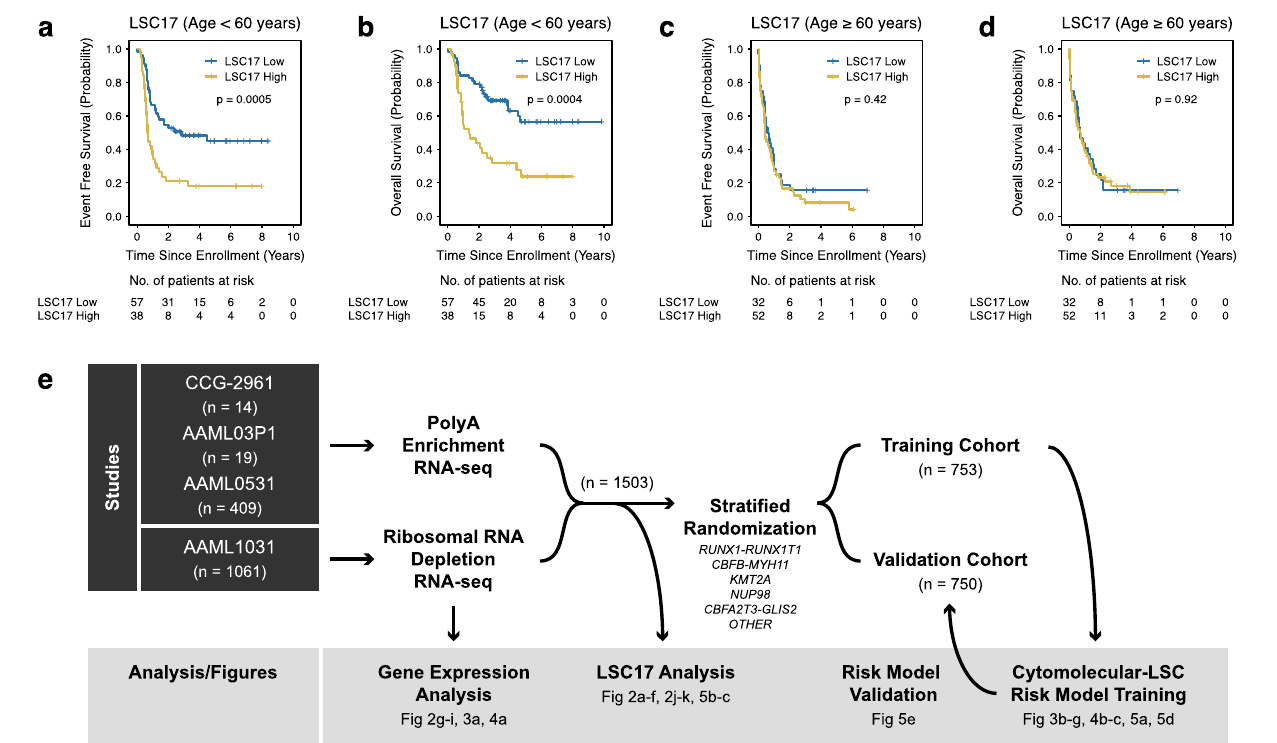
Fig. 1 | LSC17 in TCGA AML based on age. a – d Kaplan – Meier estimates for the probabilityofeventfreesurvival(EFS)andoverallsurvival(OS)inpatientsfromThe Cancer Genome Atlas (TCGA) AML cohort segregated based on age. a , b LSC17 scores predict survival in younger adults (<60 years of age). c , d Conversely, LSC17 scores do not discriminate between favorable and unfa- vorable outcomes in older adults ( ≥ 60 years of age). Survival differences were determined using the log-rank test (two-sided and without multiple-testing